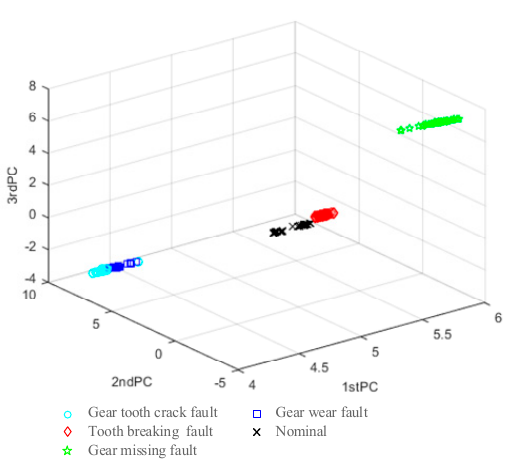
Figure 18. Clustering result of VMD-time-frequency information entropy under condition 4.